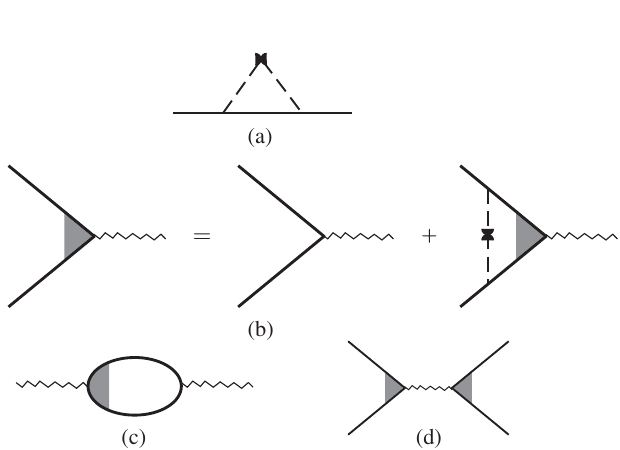
FIG. 2. (a) The impurity self-energy leading to the elastic lifetime in Eq. (2.3). (b) Disorder correction to the electron interaction vertex in Eq. (2.6); here and henceforth, the electron lines contain the effect of the impurity self-energy. (c) Dynamical screening of the interaction by the disorder-corrected polarization bubble in Eq. (2.7). (d) The 2-in, 2-out process that provides the inelastic electron lifetime; here and henceforth, the interaction line is the dynamically screened